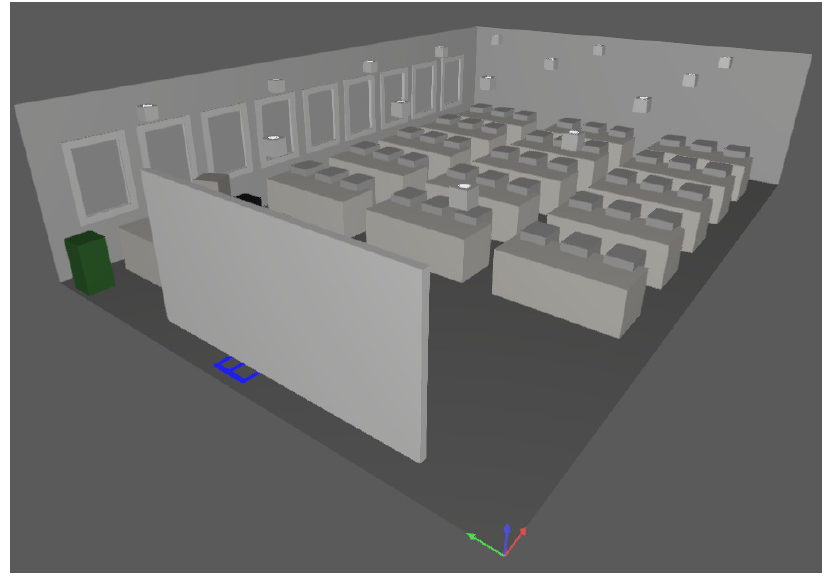
Figure 1. The overall layout of case study room modelling in DIALux software.